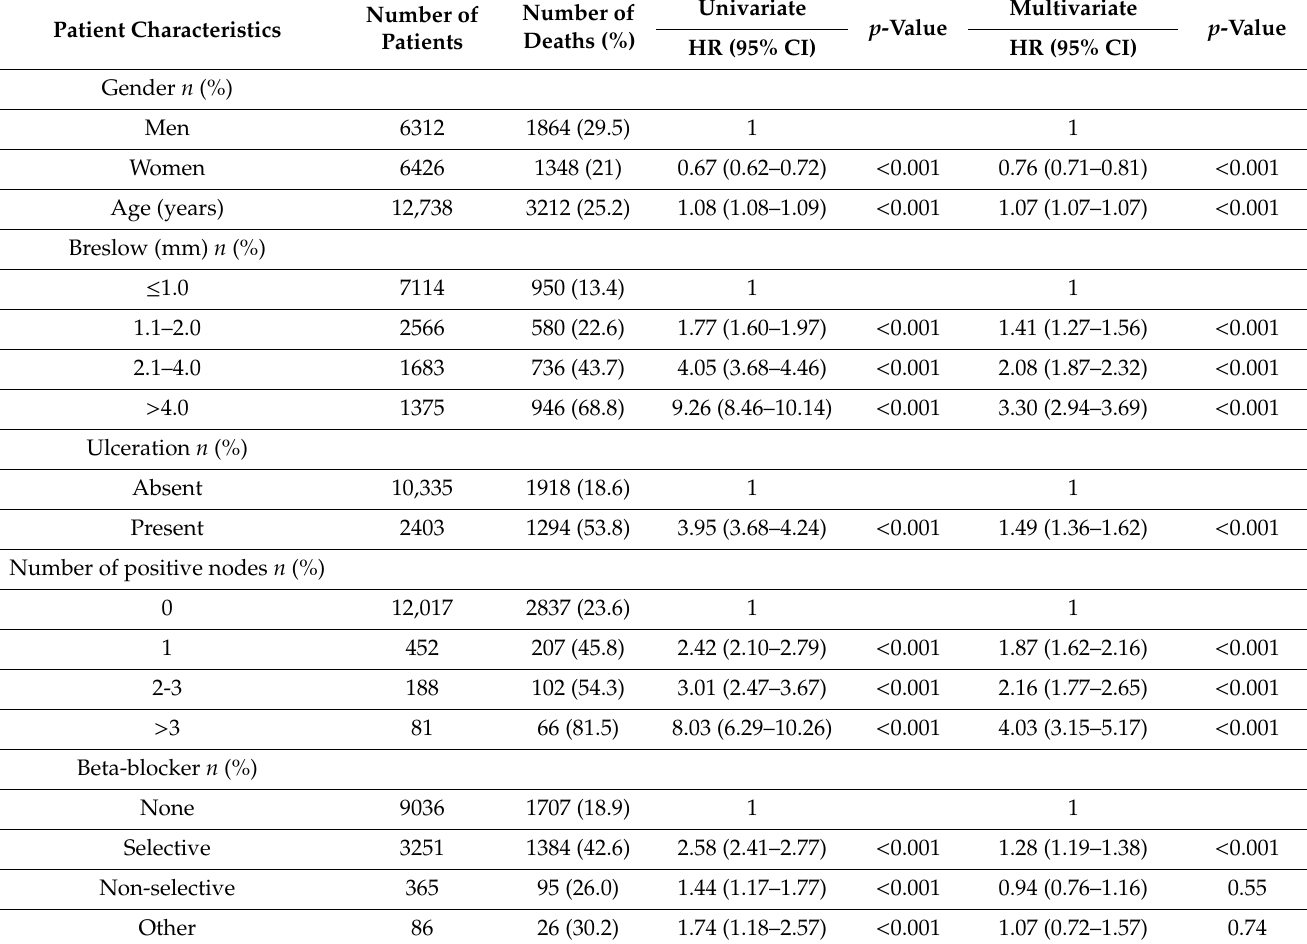
Table 3. Overall survival (OS) in patients with stage I–III primary cutaneous melanoma diagnosed between 2009 and 2013 in Sweden. Patient